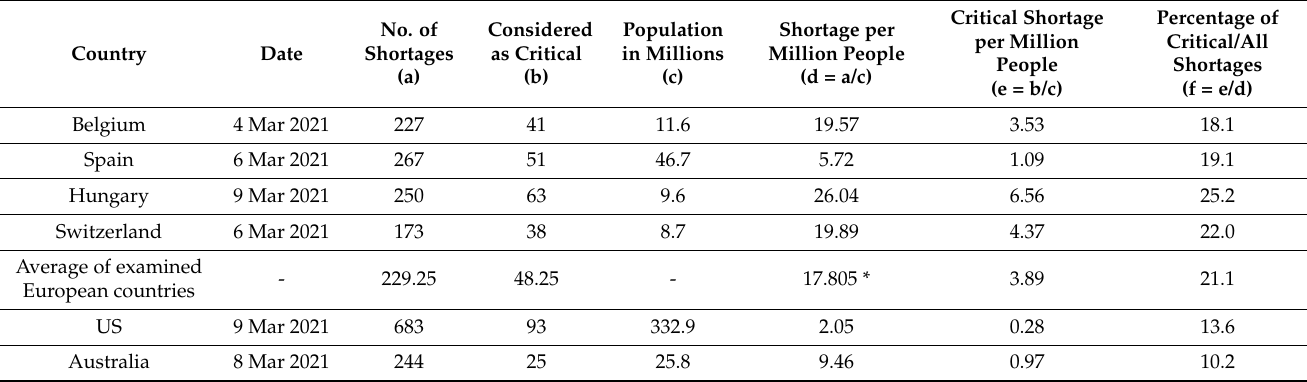
Table 3. Number of shortages per million people in the studied countries, including critical cases.